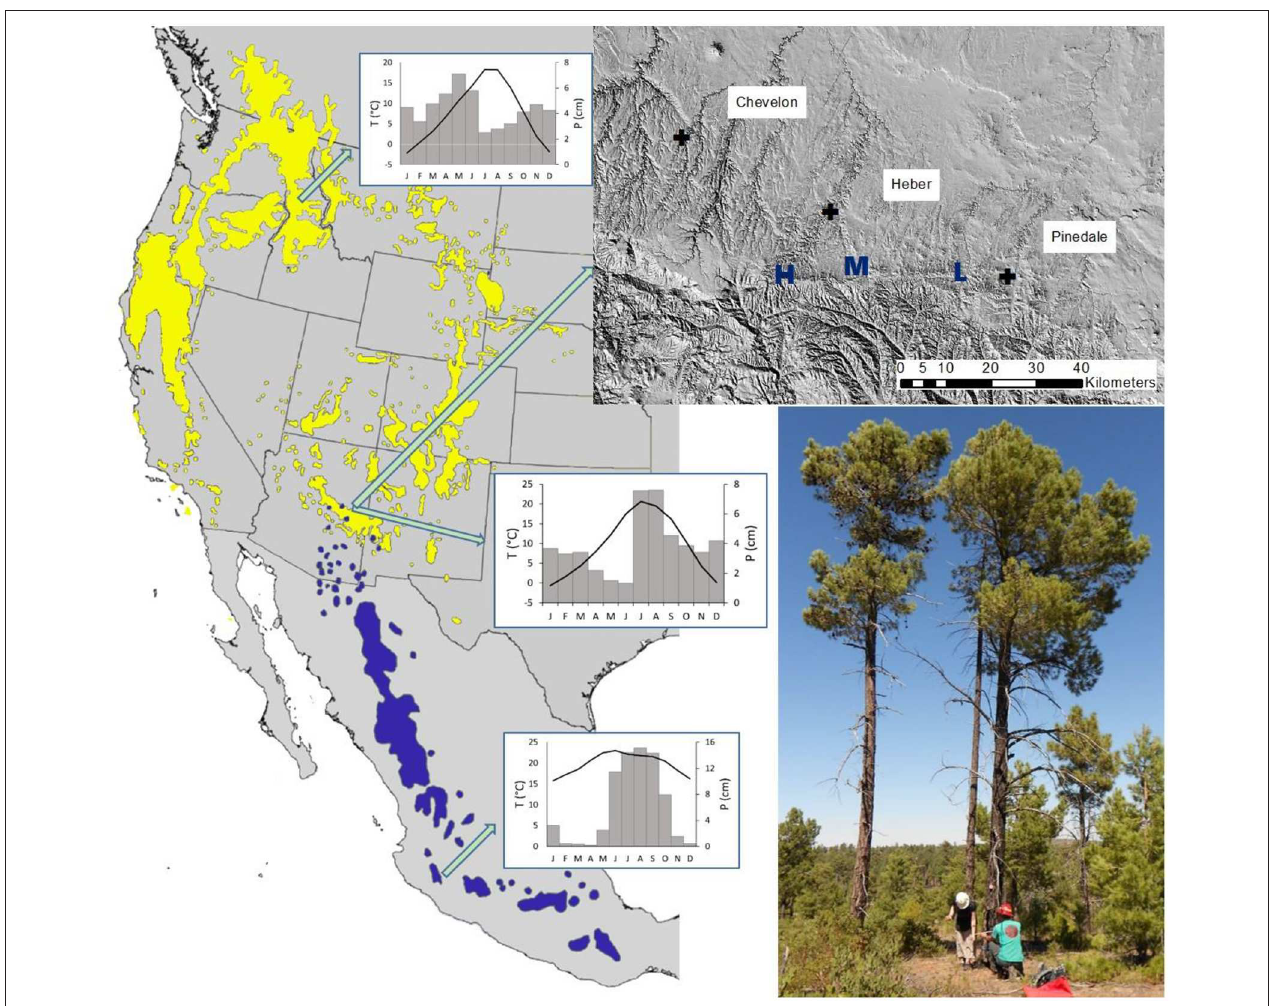
FIGURE 1 | Range of Pinus leiophylla , PILE (blue) and P. ponderosa , PIPO (yellow), maps from US Geological Survey. The study area is at the northernmost point of the PILE range. The inset map (upper right) shows the three study sites on the Mogollon Rim in Arizona, identified as High (H), Middle (M), and Low (L) elevation. The cross symbols mark the three weather stations. The inset photo (lower right) shows a pair of sampled trees with PILE on the left and PIPO on the right. Climate diagrams are from the study area (center), Nez Perce, Idaho, USA (Top) , and Ciudad Guzmán, Jalisco, Mexico (Bottom)